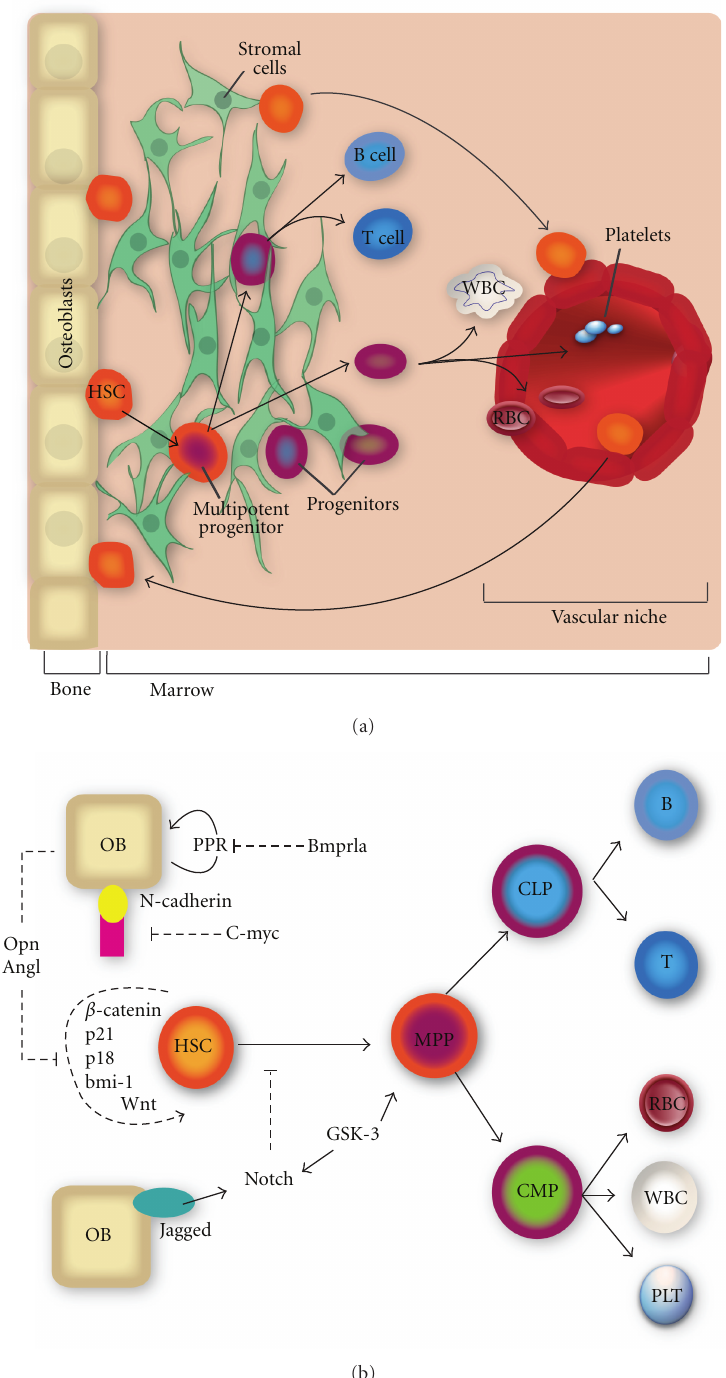
Figure 1: Quantitative aspects of the hematopoietic stem cell (HSC) niche. The left panel provides a structural picture of the niche, while the right panel shows a schematic representation of a mathematical model for the regulation of hematopoietic stem cell fate. The model incorporates population counts and signaling pathways that may play a role in regulating stem cell population dynamics. Cellular populations comprising the bone and vascular niches include osteoblasts (OBs), endothelial cells, HSCs, multipotent progenitors (MPPs), common myeloid progenitors (CMPs), common lymphoid progenitors(CLPs), and di ff erentiated cells. Signaling from Wnt, β -catenin, p21, p18, and bmi-1 regulate self-renewal, while Notch and GSK3 feedback from progenitors inhibit di ff erentiation that usually accompanies self-renewal. Signaling from osteoblasts includes osteopontin (Opn) expression that inhibits HSC self-renewal, parathyroid hormone-related protein (PPR) which increases HSCs, N-cadherin which binds β -catenin, and Tie2/angiopoietin which regulates